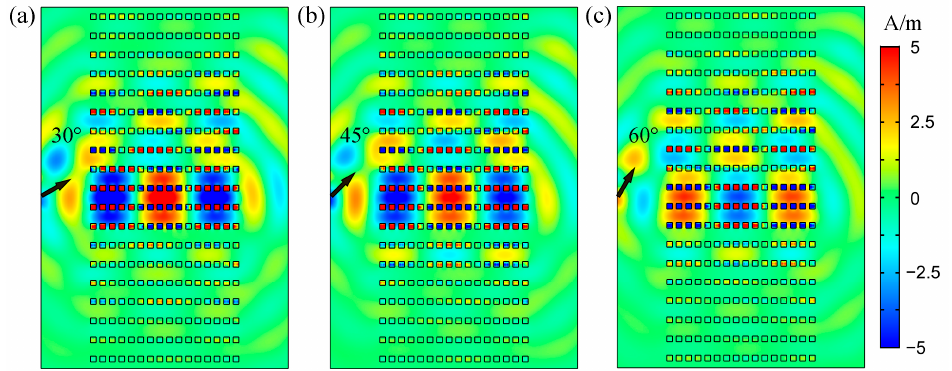
Figure 7. Magnetic field distributions of wave propagating in the PHC at 58.00 THz with pump power of 3.4 × 10 6 V/m (nonlinear regime), the incident angles are ( a ) 30°, ( b ) 45° and ( c ) 60°.